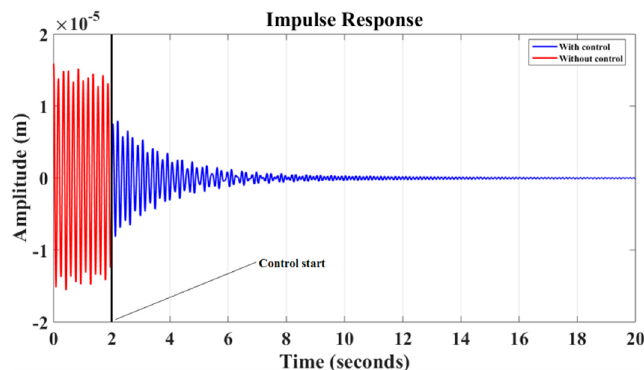
Figure 10. White noise response (Sensors in FE2, Q = 10 12 , R = 1, Gc = 100).